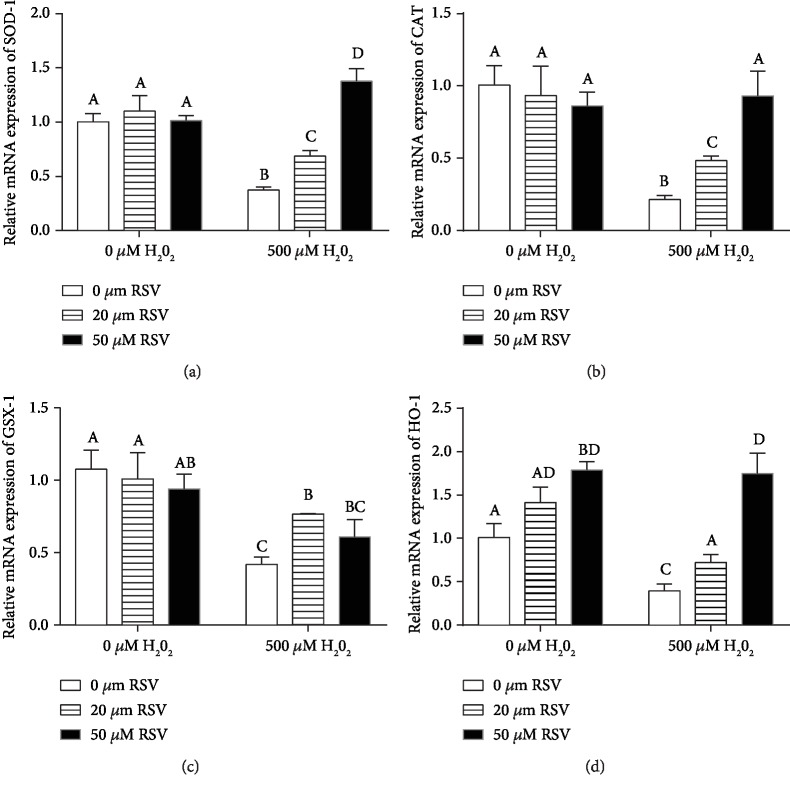
Effects of resveratrol and/or H2O2 on the expression of SOD-1, CAT, GSX-1, and HO-1 in IPEC-J2 cells. IPEC-J2 cells were pretreated with the indicated concentrations of RSV for 6 hours and then cocultured with 500 μM H2O2 for 4 hours. The expression of SOD-1 (a), CAT (b), GSX-1 (c), and HO-1 (d) was detected by qRT-PCR. Data are shown as ratios of abundance of target gene transcripts in the treated cells to those in the control cells after normalization to β-actin. Values are the mean ± SE; n = 6. The columns with the same superscript capital letters and with different superscript capital letters mean no significant difference (P > 0.05) and significant difference (P < 0.05), respectively.